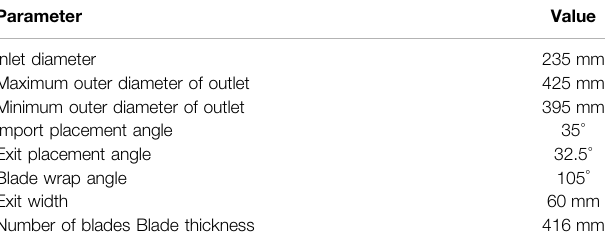
TABLE 2 | Impeller parameters of the deep-sea lifting pump.